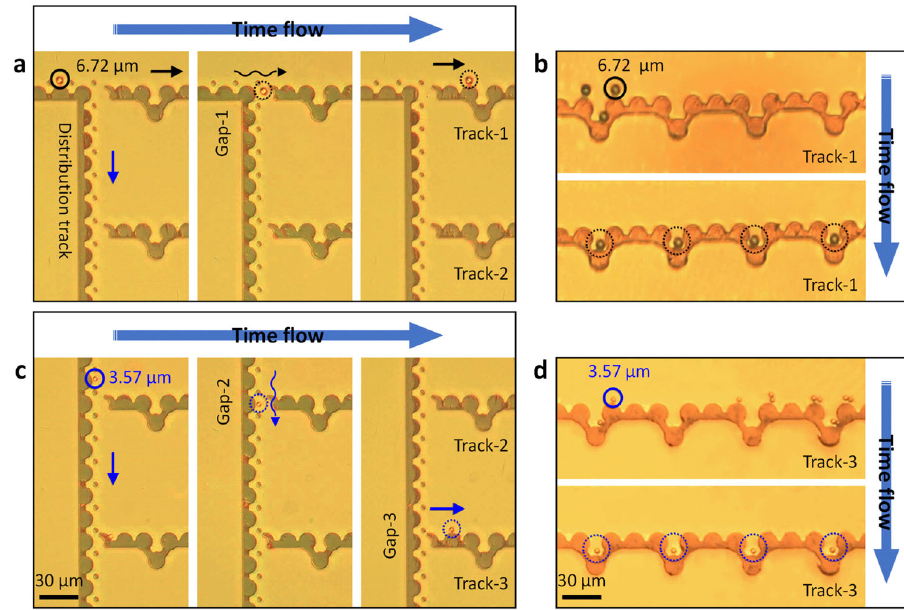
Fig. 9 Size-dependent sorting and storage of PsD holes. Sorting of PsD holes in reverse bias mode across an eclipse diode along the distribution tracks and local storage of single PsD holes in an array of compartments along storage tracks. a , b Separation of 3.57 and 6.72 µ m PsD holes by eclipse diode, where 3.57 µ m PsD holes crosses Gap-1 ( d = 15.6 µ m) and then navigate towards Gap-2 ( d = 14.3 µ m), but 6.72 µ m PsD holes enter Track-1 due to the lack of current fl ow in reverse bias mode. c , d Snapshots of transportation and occupancy of single 6.72 and 3. 57 µ m PsD holes in all the individual storage compartments along Track-1 and Track-3,